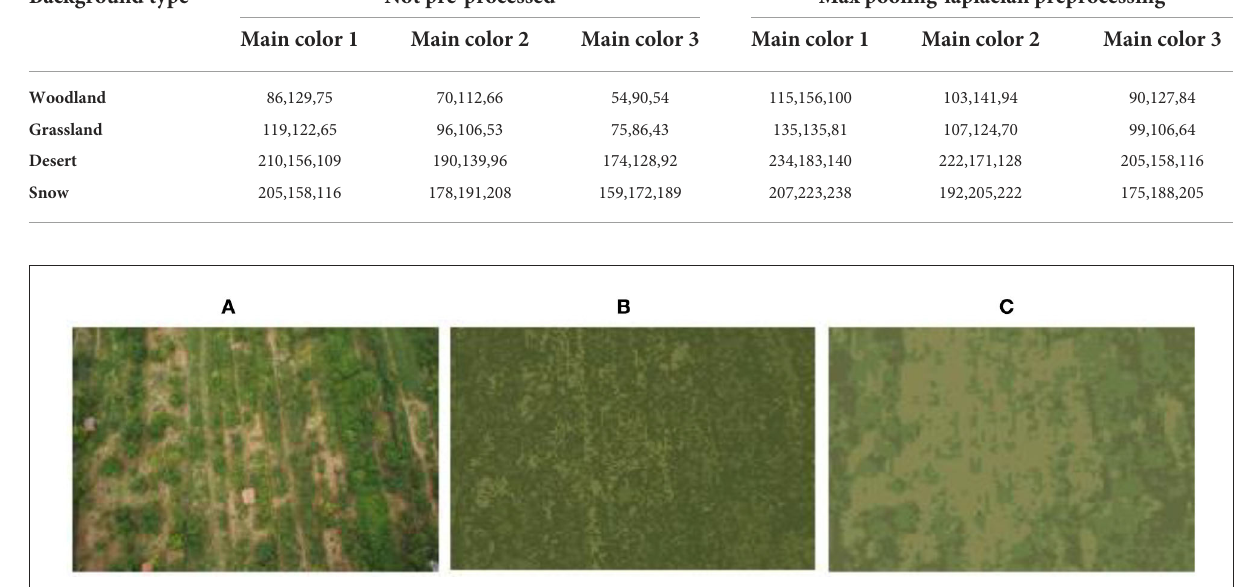
FIGURE11 Grass-type camouflage pattern. (A) Original image, (B) unprepared, (C) compressed and enhanced.